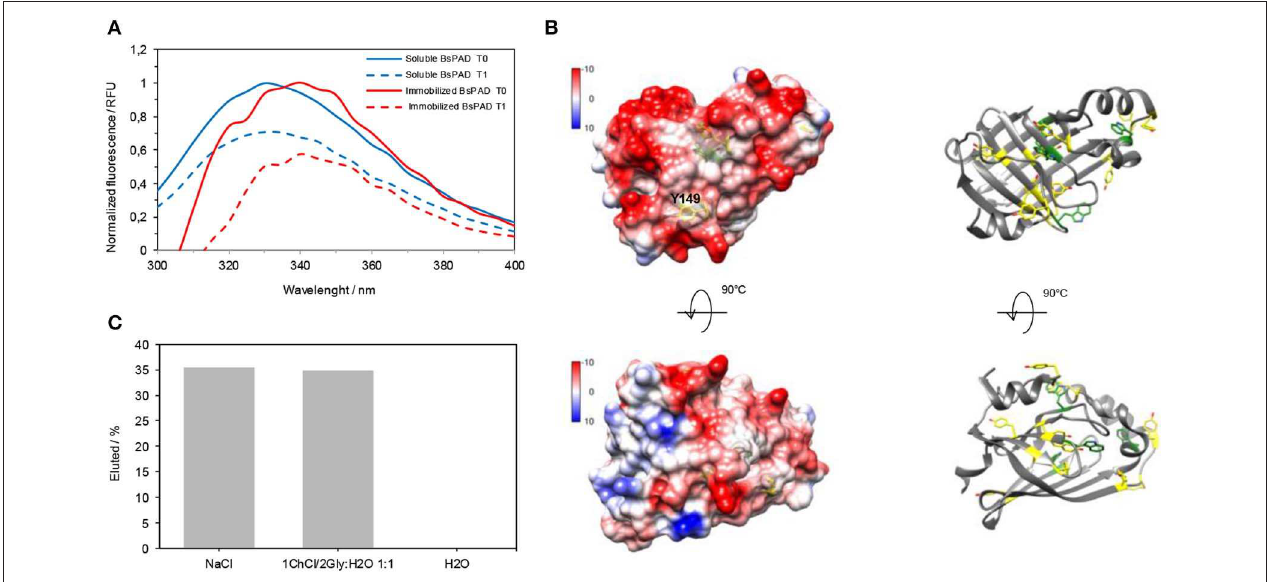
FIGURE 1 | (A) Total intrinsic fluorescence of soluble and immobilized Bs PAD using an excitation wavelength of 280nm. T0 (solid lines) correspond to spectra of the non-incubated enzymes, while T1 (dashed lines) do to enzyme incubated for 1h at 45 ◦ C. Data were normalized assigning a value of 1 to the highest fluorescence intensity value for each sample non-thermally incubated (sample T0s). (B) Electrostatic surface representation of Bs PAD (PDB ID: 2P8G). Tryptophan and tyrosine residues are colored in green and yellow, respectively. Images were made with Chimera software. (C) Percentage of protein eluted from the carrier after an incubation of 1h with 1M NaCl, a solution of (1 ChCl /2 Gly :H 2 O 1:1) and H 2